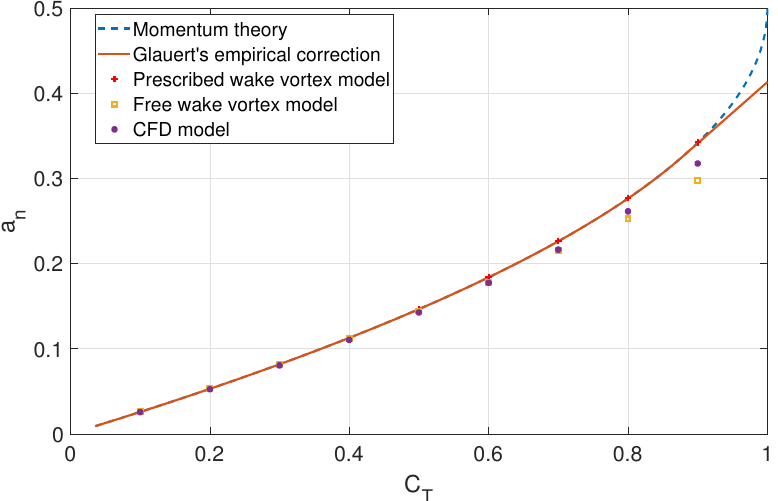
Figure 2. Comparison of momentum balance with different models at the center point of actuator disk where z/R = 0, y/R = 0 and yaw angle = 0